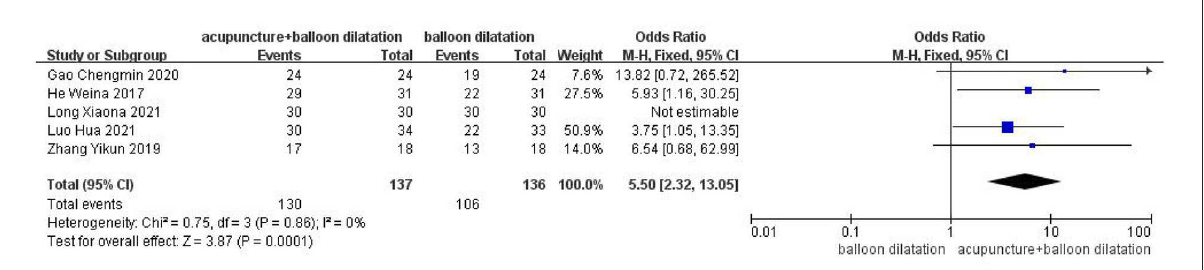
FIGURE3 Forest plot for the effective rate.